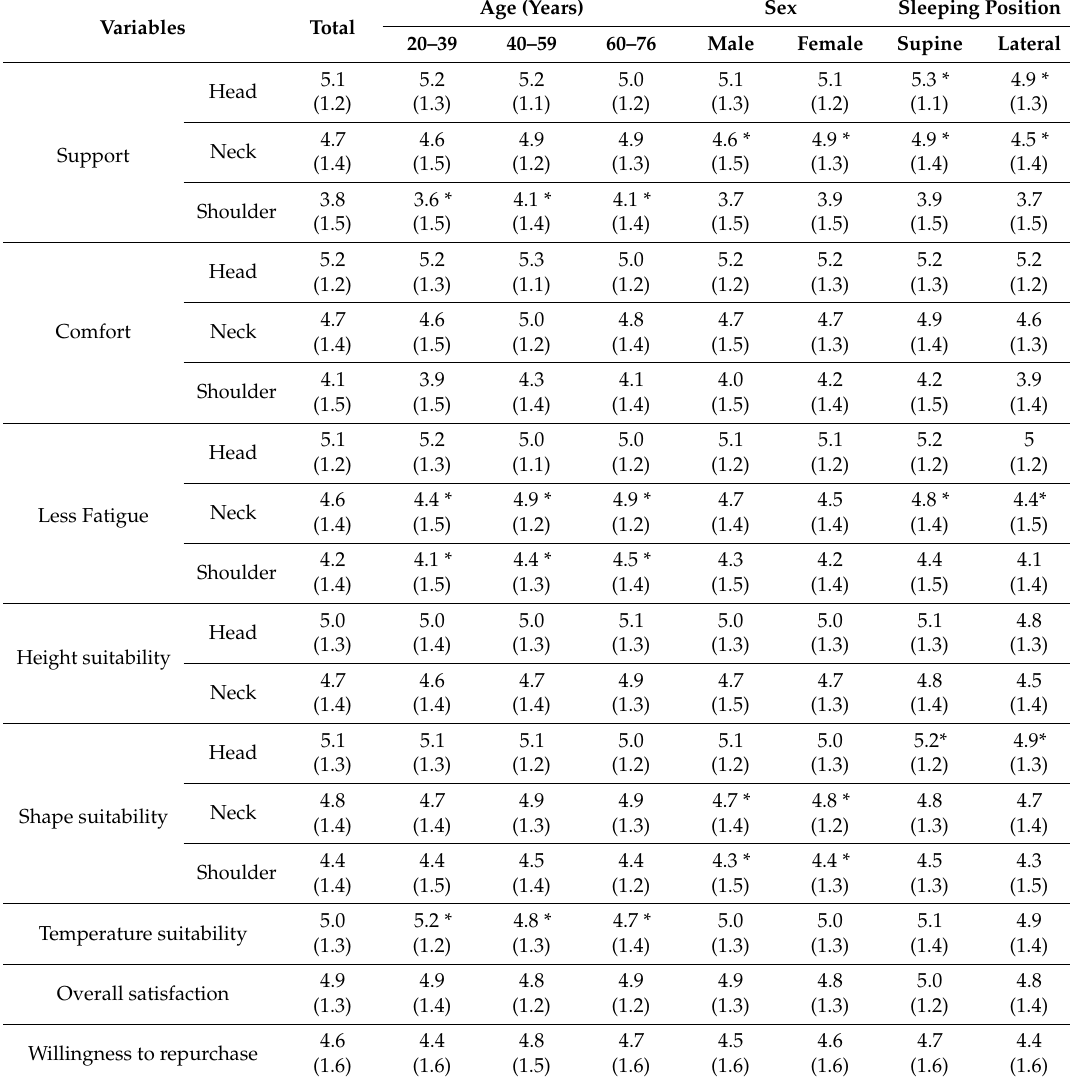
Table 5. T-test and ANOVA results for comfort and support characteristics of pillows (Mean (S.D.)).